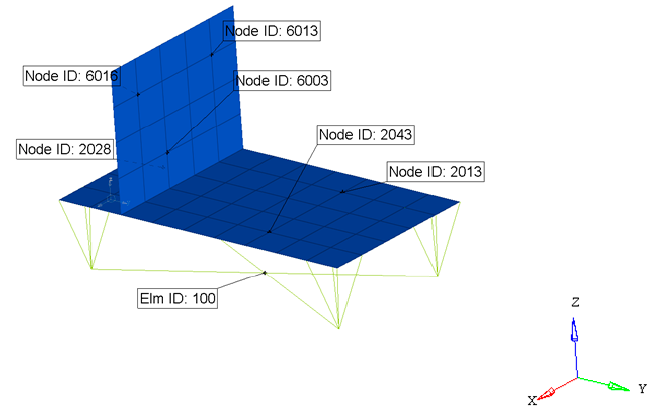
Figure 4. The academic use case with six highlighted sensors and element 100.